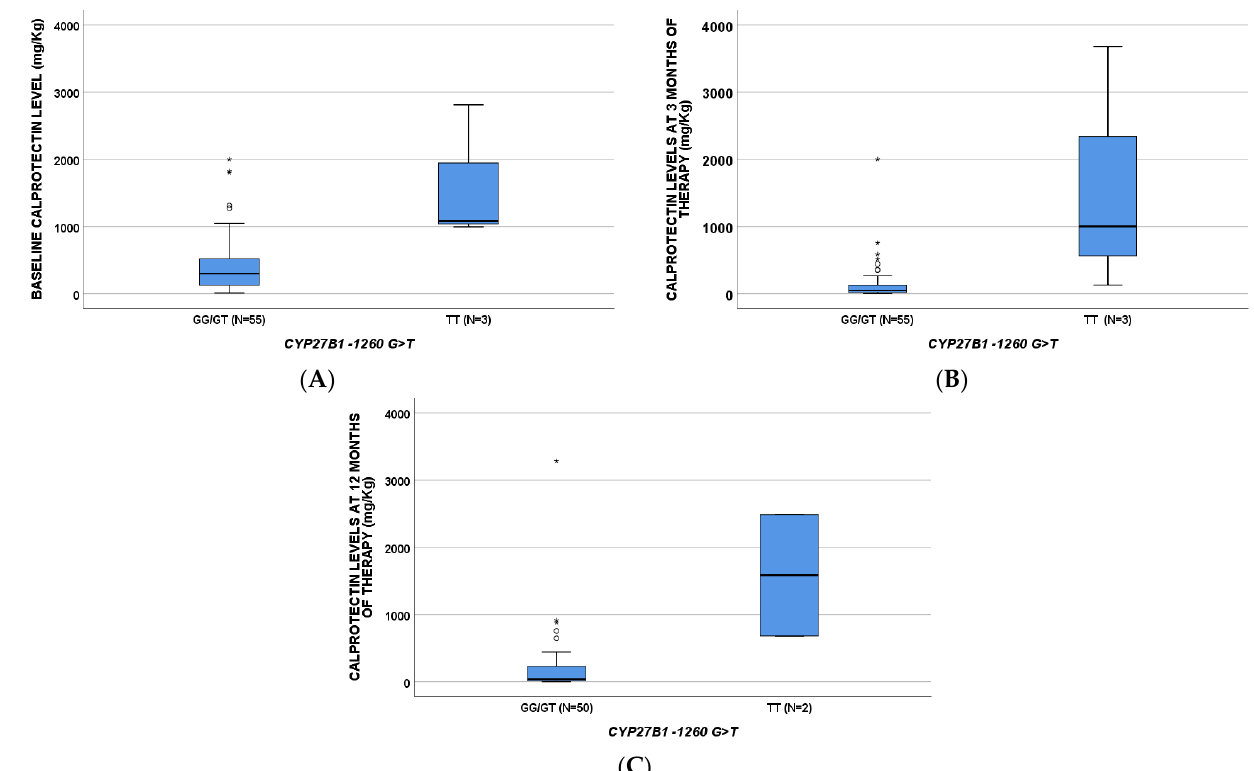
Figure 1. Calprotectin levels according to CYP27B1 -1260G>T SNP at baseline ( A , p = 0.018), three ( B , p = 0.015), and twelve ( C , p = 0.018) months of therapy. p -values are obtained through Mann–Whitney test. * Circles and stars indicate “out” values (small circle) and “far out” values